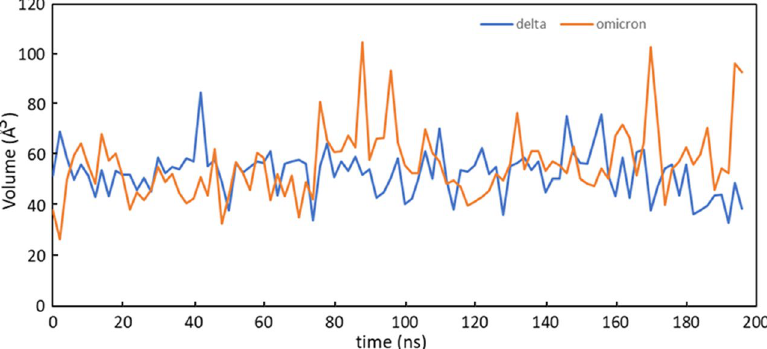
Figure 2. Binding-pocket volumes of Delta (blue) and Omicron (orange) plotted as a function of